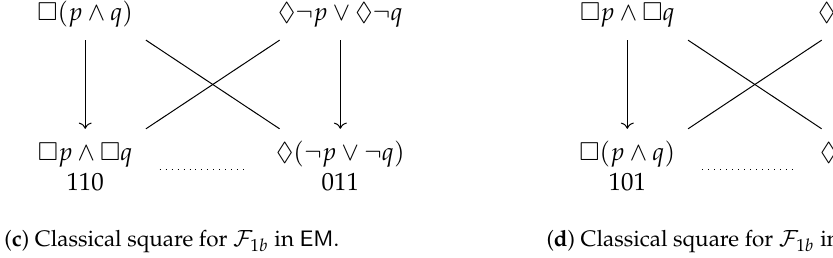
Figure 4. Aristotelian diagrams for F 1 b : = { (cid:3) ( p ∧ q ) , (cid:3) p ∧ (cid:3) q , ♦ ¬ p ∨ ♦ ¬ q , ♦ ( ¬ p ∨ ¬ q ) } in any normal modal logic and in three non-normal modal